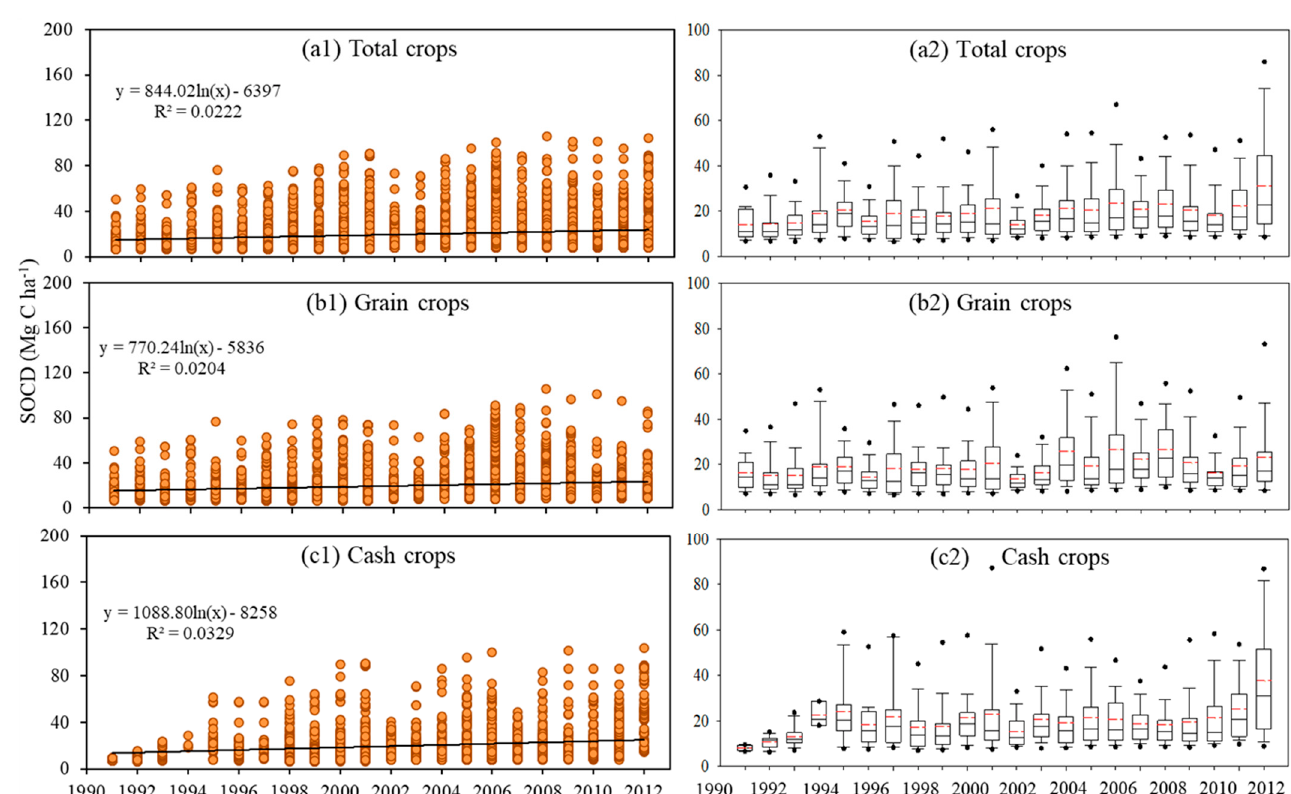
Figure 2. Trends of soil organic carbon density (SOCD) for ( a1, a2 ) total crops, ( b1, b2 ) grain crops and ( c1, c2 ) cash crops in China’s croplands from 1991 to 2012.